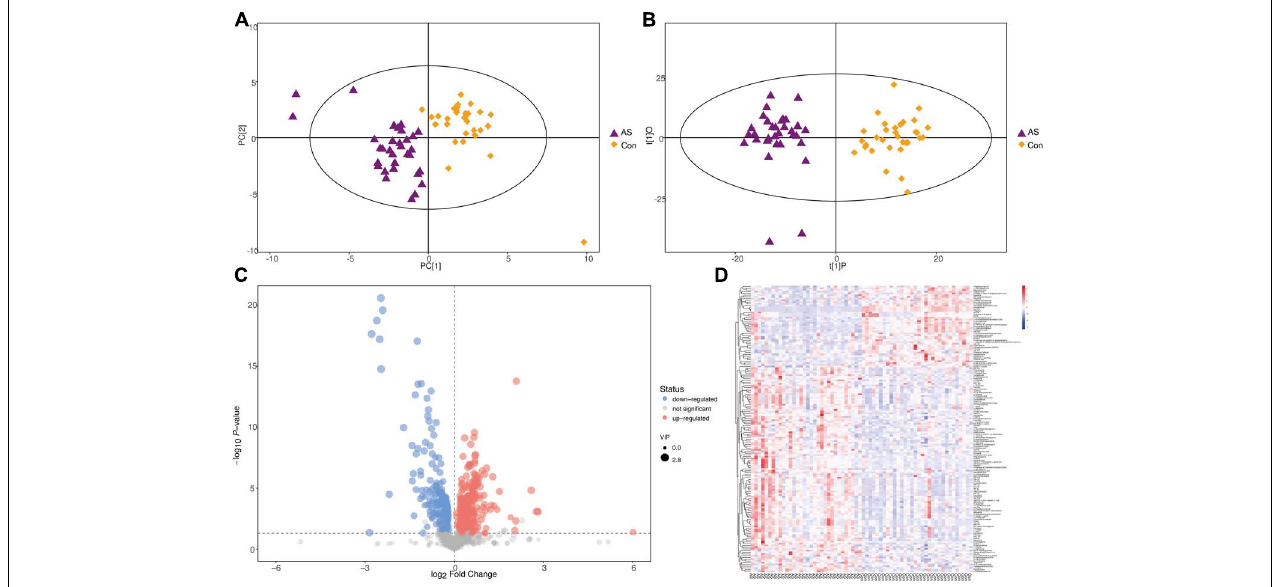
FIGURE 5 | Differential metabolites screening for CAS patients and healthy controls (POS mode). (A,B) PCA and orthogonal projections to latent structures-discriminant analysis showed that CAS patients and healthy controls could be clearly separated. (C,D) Patterns of differential metabolites in POS mode were demonstrated by volcano plot and heatmap.